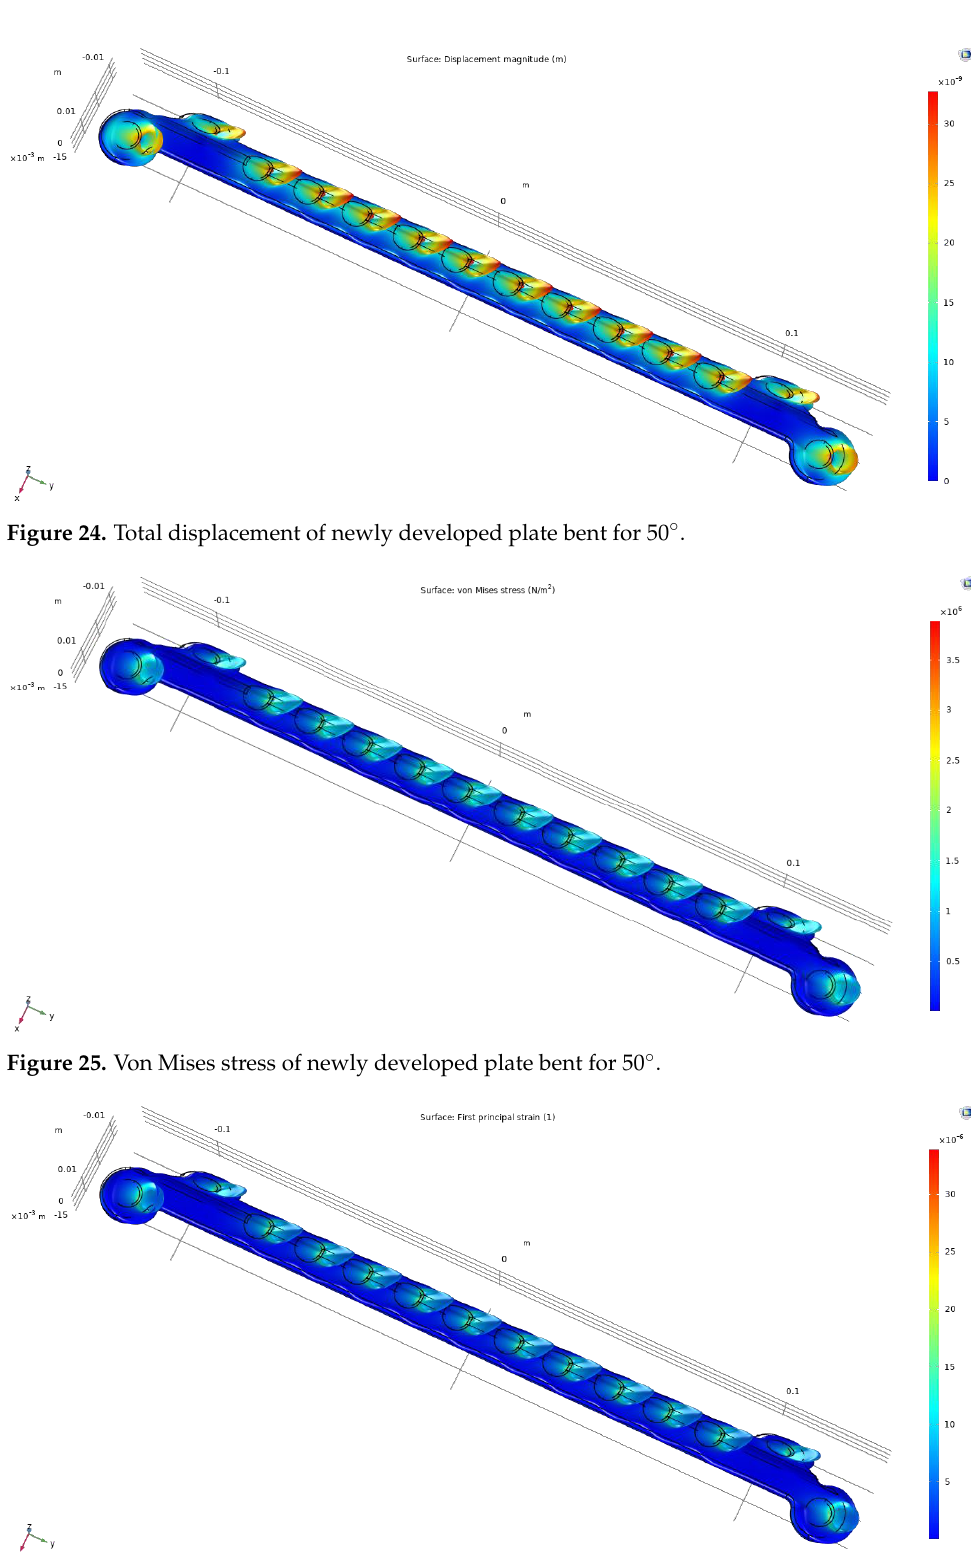
Figure 26. First principal strain of newly developed plate bent for 50°.